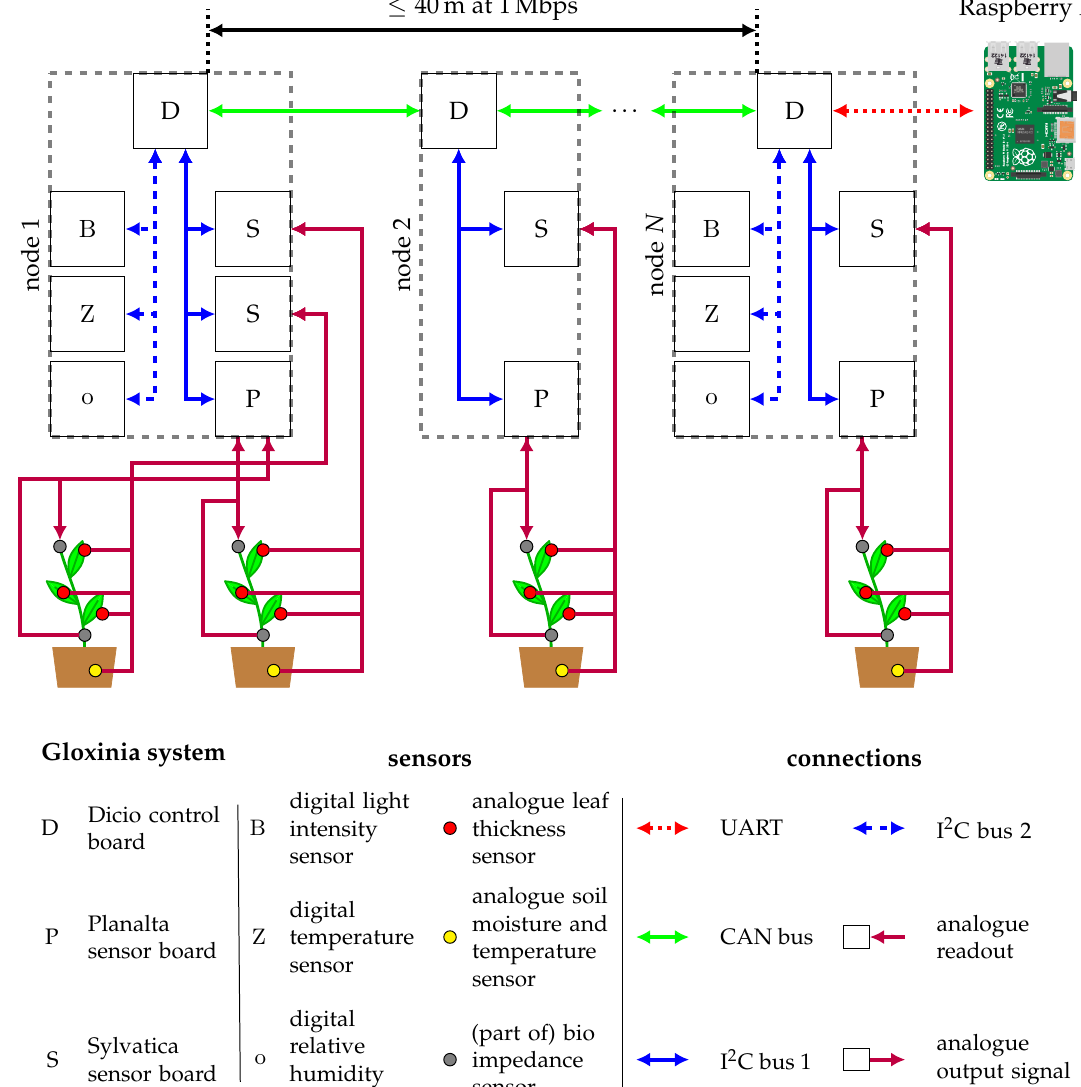
Figure 1. System architecture of a typical experiment where multiple plants are monitored using the same set of sensors. Analogue sensors are connected to Planalta and Sylvatica, depending